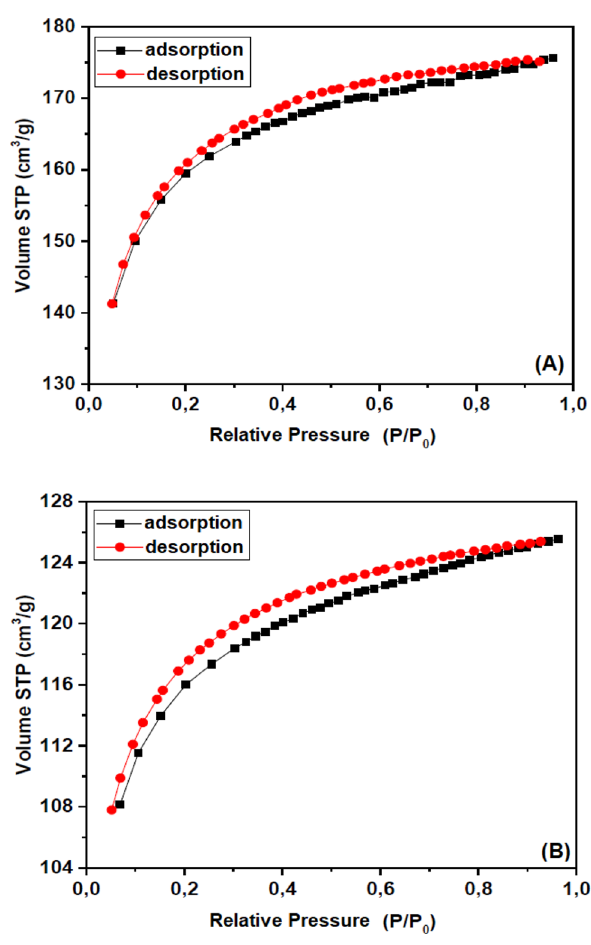
Figure 2. Nitrogen adsorption–desorption isotherm of SiTiNb-A (A) and SiTiNb-B (B) ternary